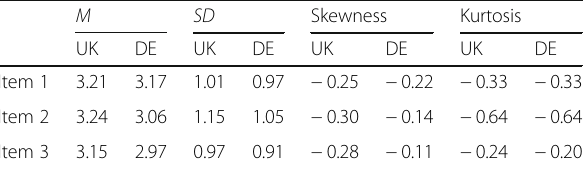
Table 3 Descriptive statistics for the KUSIV3 items